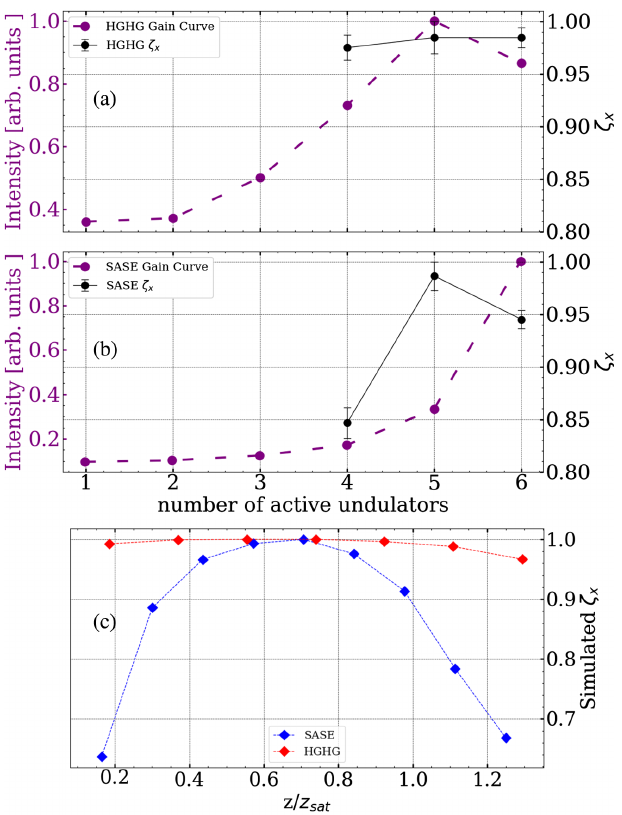
FIG. 4. Gain curve (purple) and total degree of transverse coherence ζ x (black) (normalized to unity), as a function of the distance in the second-stage radiator, for (a) HGHG and (b) SASE. Simulated total degree of transverse coherence for SASE (blue) and HGHG (red)